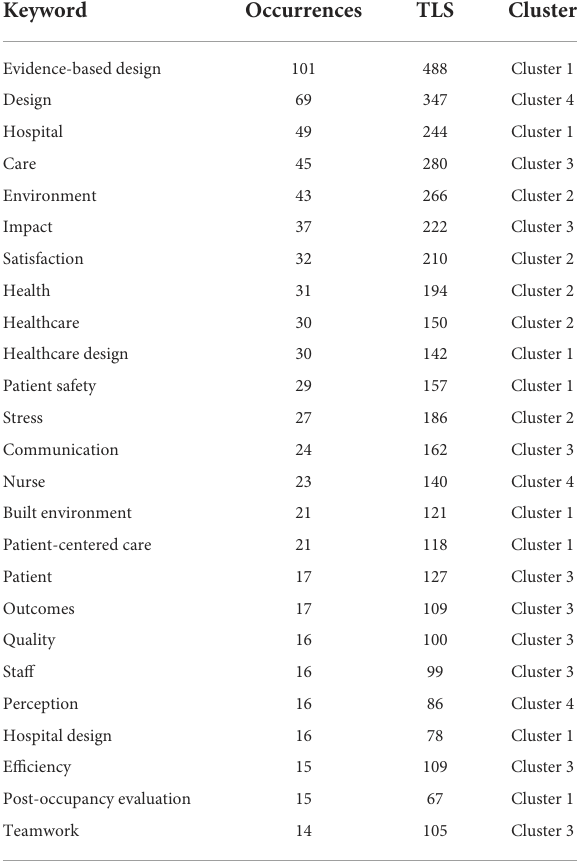
TABLE 3 Top 25 most frequently occurring keywords in the articles selected from